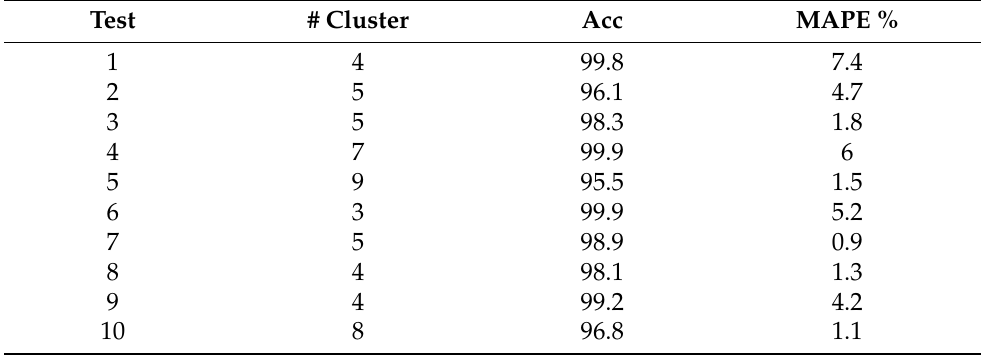
Table 5. Results for a sample of 10 appliances.